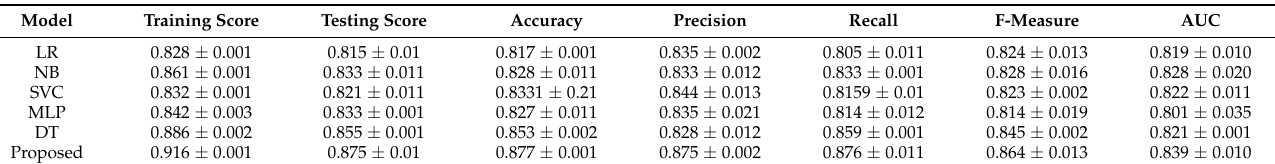
Table 2. Results of the prognosis model after 1 month.